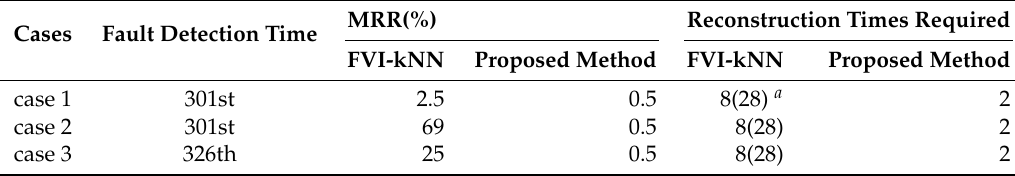
Table 1. The summarized results of the numerical case